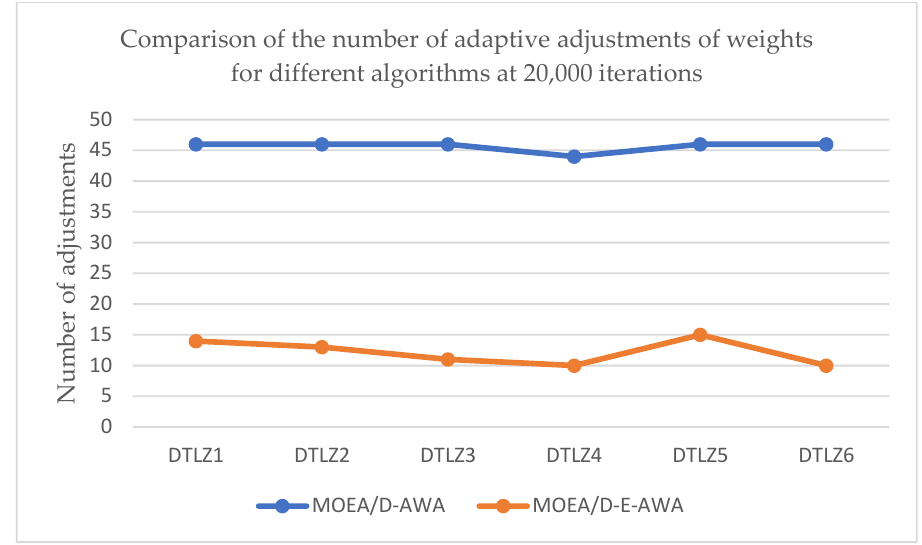
Figure 3. Comparison of weight adaptive adjustment times of M-E-AWA and MOEA/D-AWA al- gorithms when the maximum number of iterations is 15,000.